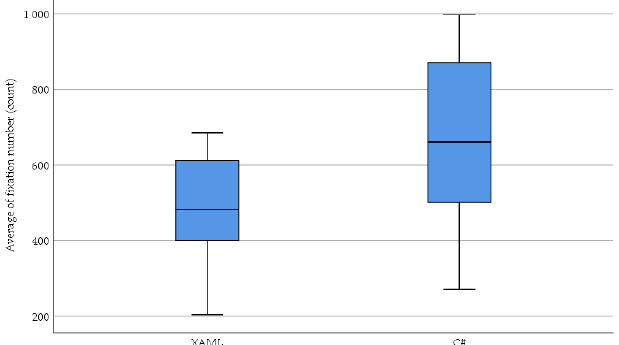
Figure 10. The distribution of the number of fixations (count) based on XAML and classic C#. In response to the RQ2 question, a signi fi cant di ff erence was found in the average fi xation number ( p = 0.002) when the test subjects read and understood the source codes based on XAML or classic C#. The results show that less fi xation number, i.e., a focus point number or recording of information, was necessary in the case of the XAML-based UI description. 4.3.3. Average of Pupil Diameter Based on AOIs The descriptive statistical table of the recorded average pupil diameter results can be seen in Table 4 for XAML and classic C#. Table 4. The descriptive statistic of the average pupil diameter is based on XAML and classic C# ( n = 36).